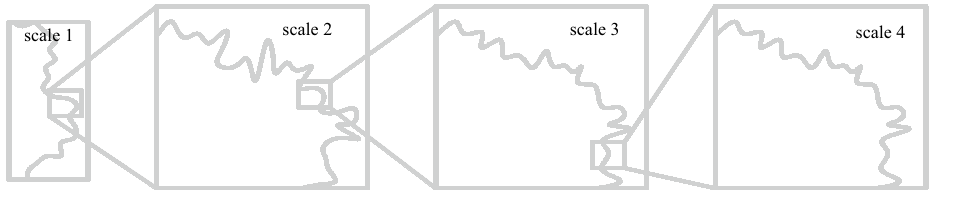
Figure 4. Multi-scale points